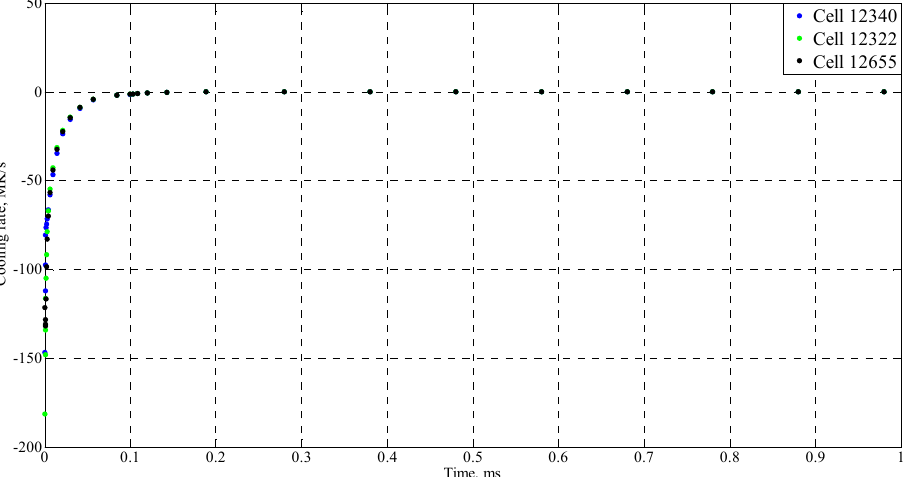
Figure 15. Cooling rate (CR) evolution in the splat cells 12340, 12322 and 12655.